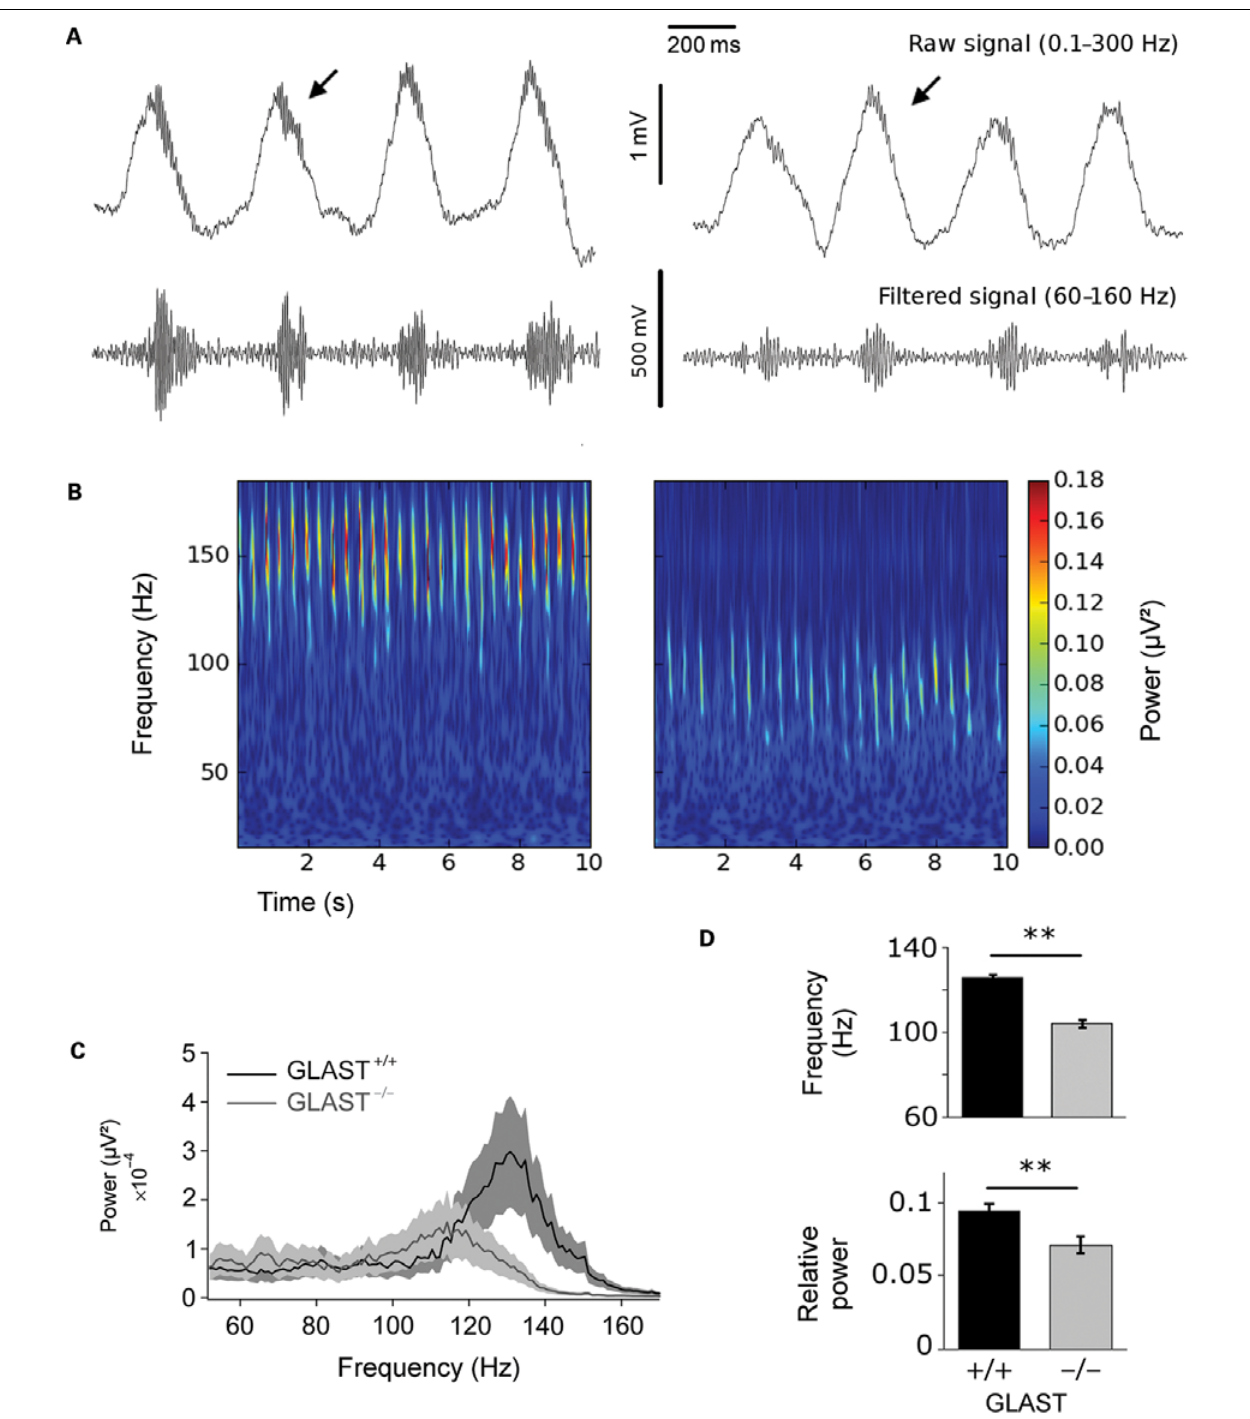
FIGURE 3 | Gamma activity recorded during spontaneous activity in the olfactory bulb of GLAST + / + and GLAST − / − mice. (A) Gamma bursts are present on each respiratory cycle, both in a GLAST + / + mouse (left) and a GLAST − / − mouse (right) as displayed on representative local field potential recording examples. Top : raw signals 0.3–300 Hz; bottom : filtered signals 60–160 Hz. (B) Shift of gamma bursts frequency in GLAST − / − mice.The signal is represented as a time ( x -axis)–frequency ( y -axis) decomposition